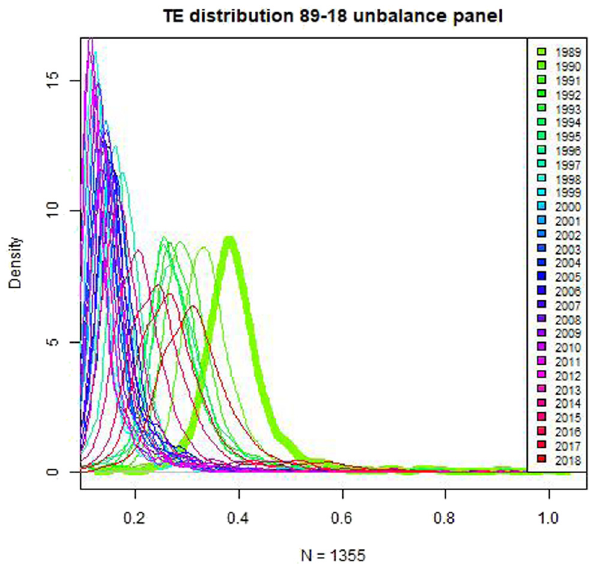
Figure 2: Distribution of TE in the unbalanced panel.